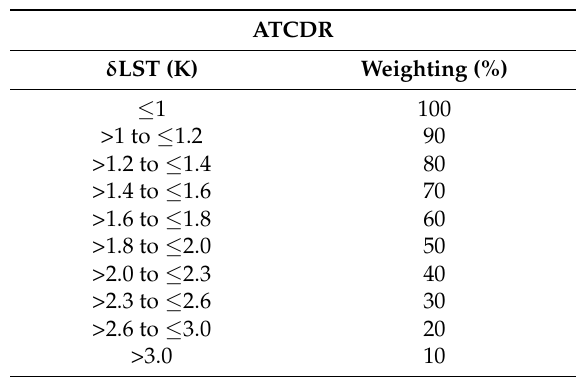
Table 4. Weighting of the meteorological stations according to the uncertainty ( δ ) of the land surface temperature (LST) product from